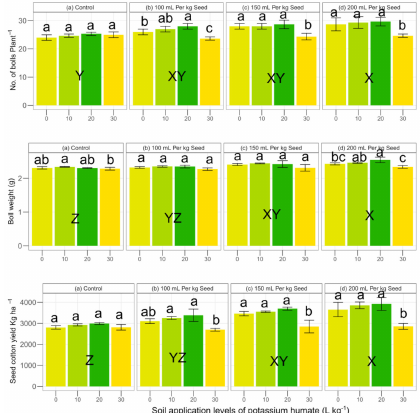
Figure 4. E ff ect of potassium humate on the number of bolls plant − 1 , average boll weight and the yield of seed cotton. Within the seed dressing application, the same lowercase letter (s) a, b, or c, indicates that the soil potassium humate application rates are not statistically di ff erent from each other at p < 0.05. Among the seed dressings, the same uppercase letter (s) W, X, Y or Z, showed a non-significant e ff ect. Error bars represent the standard deviation of the mean (n = 3, three replications).